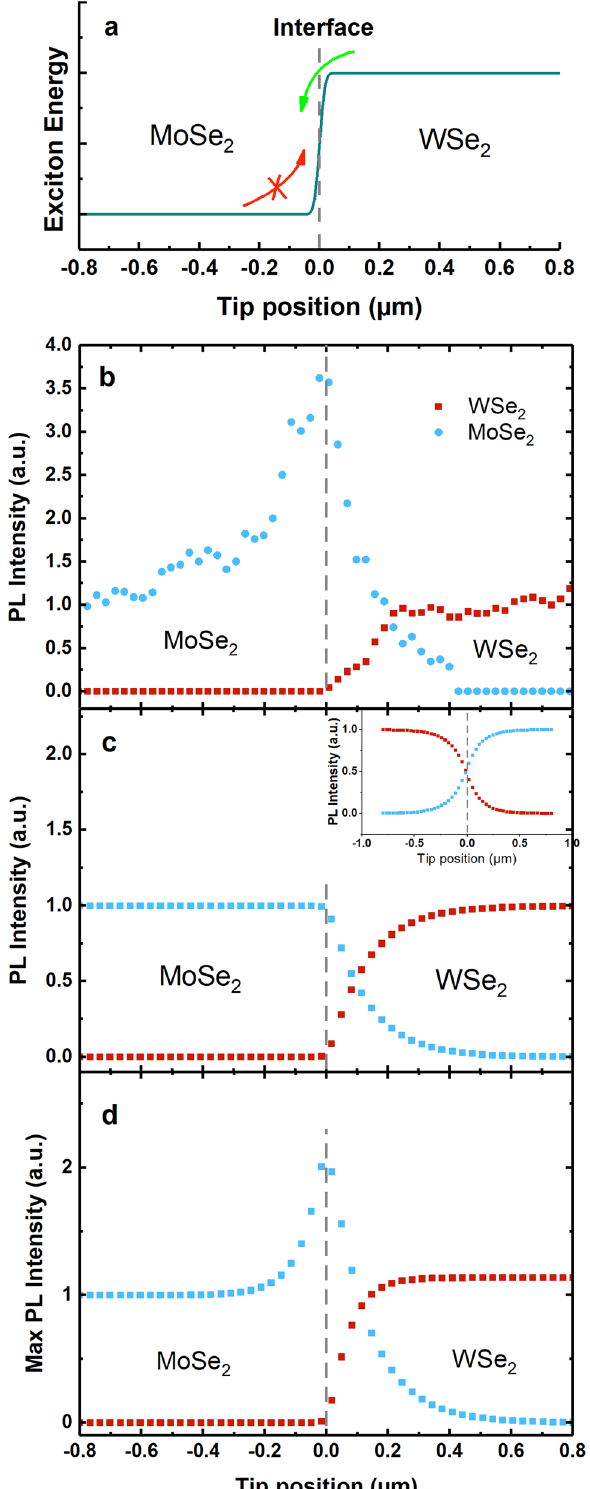
Fig. 4 Modeling near fi eld optical spectrocopy of the junction. a Scheme of the exciton energy between the two materials. b Experimental values of the PL integrated intensity as a function of the tip position for the two materials. The bright and dark contributions in WSe 2 have been added and PL integrated intensities have been normalized away from the junction. c Modeling results of the spatially integrated PL intensity assuming a perfect collection of all photons. Inset: results without considering an energy difference at the junction. d Modeling results of the PL intensity at the maximum of the PL pro fi